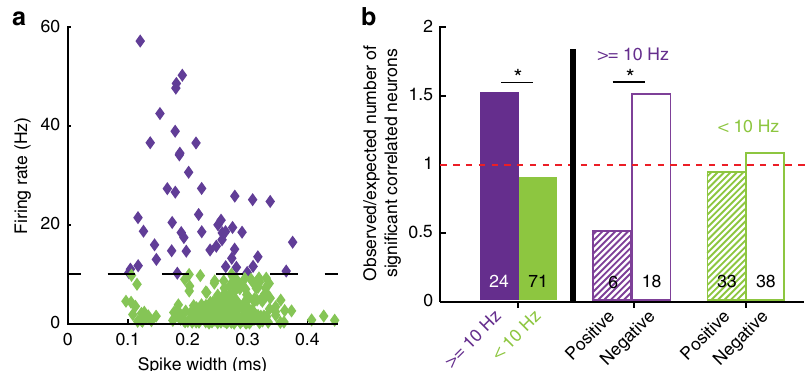
Fig. 3 High- fi ring neurons are negatively correlated with task performance. a Scatter plot for fi ring rates versus spike width of all recorded neurons. Threshold for separation of high (purple) and low (green) fi ring neurons was arbitrarily set at 10 Hz. b Comparison of different groups for neurons with signi fi cant correlation between fi ring rate and task-performance of the animal. Y -axis indicates the ratio between observed number of signi fi cantly correlated neurons in a group and numbers expected by chance. Numbers at the bottom of each bar indicate n of each group. * indicates p < 0.05; Χ 2 test. “ ≥ 10 Hz ” (purple) and “ < 10 Hz ” (green) indicate neurons with respective fi ring rates above or below 10